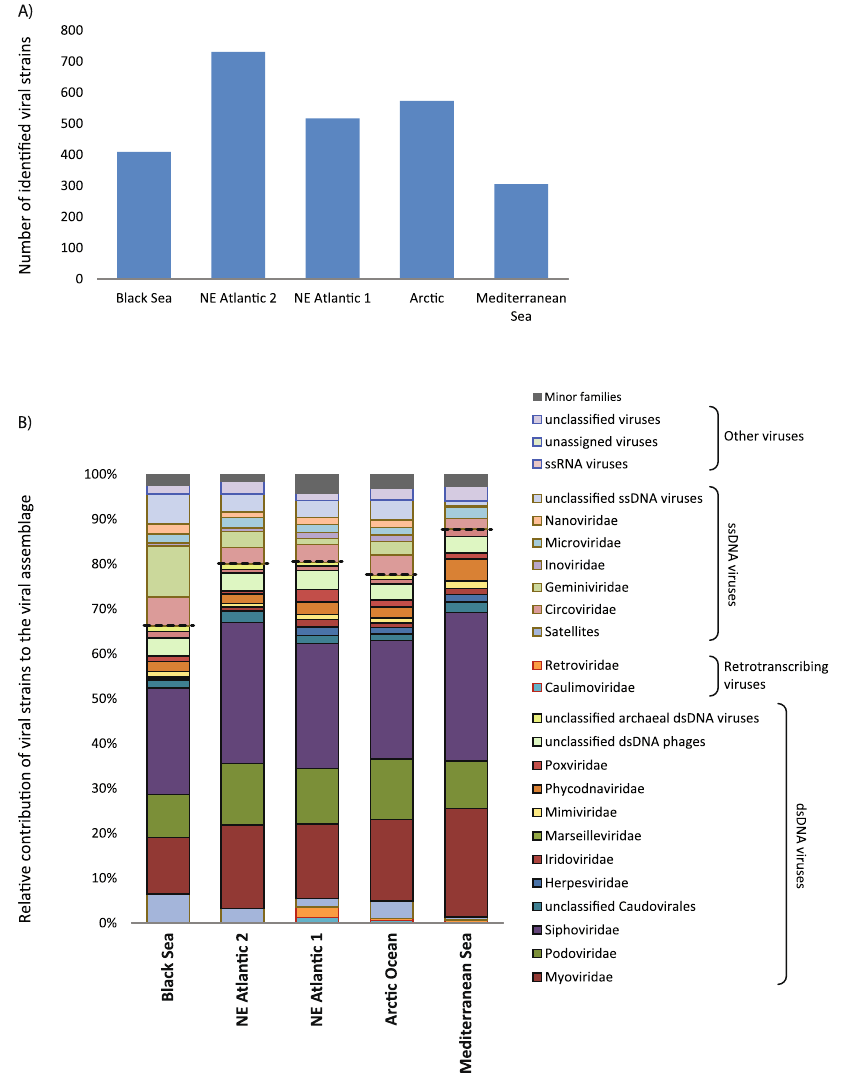
Figure 4. Viral genotype richness ( A ) and taxonomic composition of the viral assemblages ( B ) for each site investigated. The taxonomic composition is expressed as the contribution of viral genotypes to the different viral families. Dashed lines were used to separate ssDNA and dsDNA viral